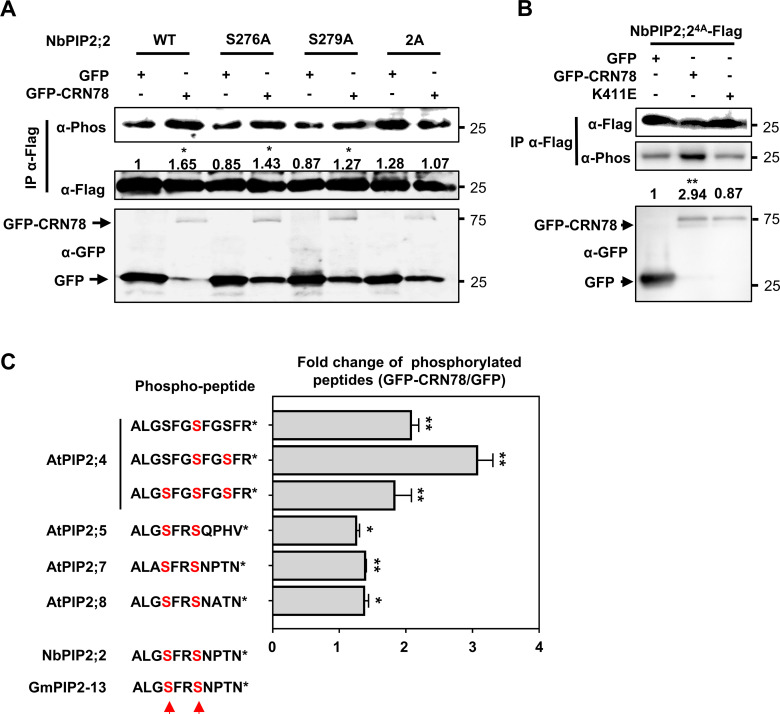
CRN78 phosphorylates NbPIP2;2 at Ser276 and Ser279 in planta.(A) Phosphorylation of NbPIP2;2 by CRN78 in vivo.
GFP-CRN78 or GFP together with NbPIP2;2 or the indicated mutants were transiently co-expressed in N. benthamiana leaves, and α-Flag IP was performed to remove the background. Phosphorylation of NbPIP2;2 was conducted by α-Phos immunoblotting. Numbers below the blots represent the relative abundance of phosphorylated NbPIP2;2. α-Flag immunoblotting was used to show equal loading. (B) Phosphorylation of NbPIP2;2 by CRN78 in vivo. Numbers below the blots represent the relative abundance of phosphorylated NbPIP2;2. α-Flag immunoblotting was used to show equal loading. (C) Enrichment of aquaporin phosphorylated peptides in samples with CRN78. Six phosphorylated peptides of AtPIP2 proteins identified in the LC-MS/MS assay are shown (top left). Predicted phosphorylation sites in NbPIP2;2 and GmPIP2-13 are listed (bottom left). Bar graph (right) shows the relative fold changes of the six phosphorylated peptides (mean ± SD; n = 3; *, P < 0.05 **, P < 0.01, Student’s t-test).